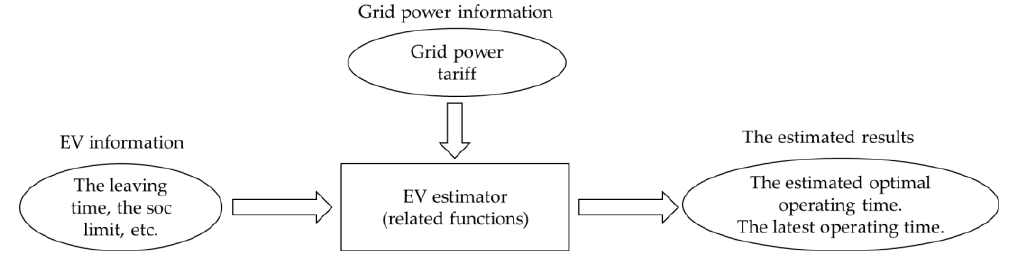
Figure 4. Method to estimate the optimal start operating time.